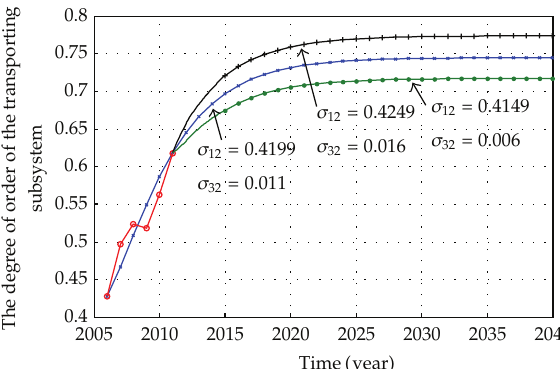
Figure 7: The ordered synergistic coevolution of the transporting subsystem with di ff erent synergistic coe ffi cients.